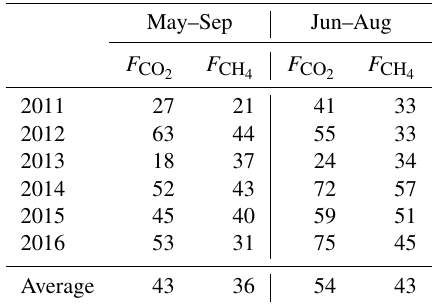
Table 1. Fraction of 30min EC fluxes of CO 2 and CH 4 remaining after the quality checks and u ∗ filtering, in percent of the specified